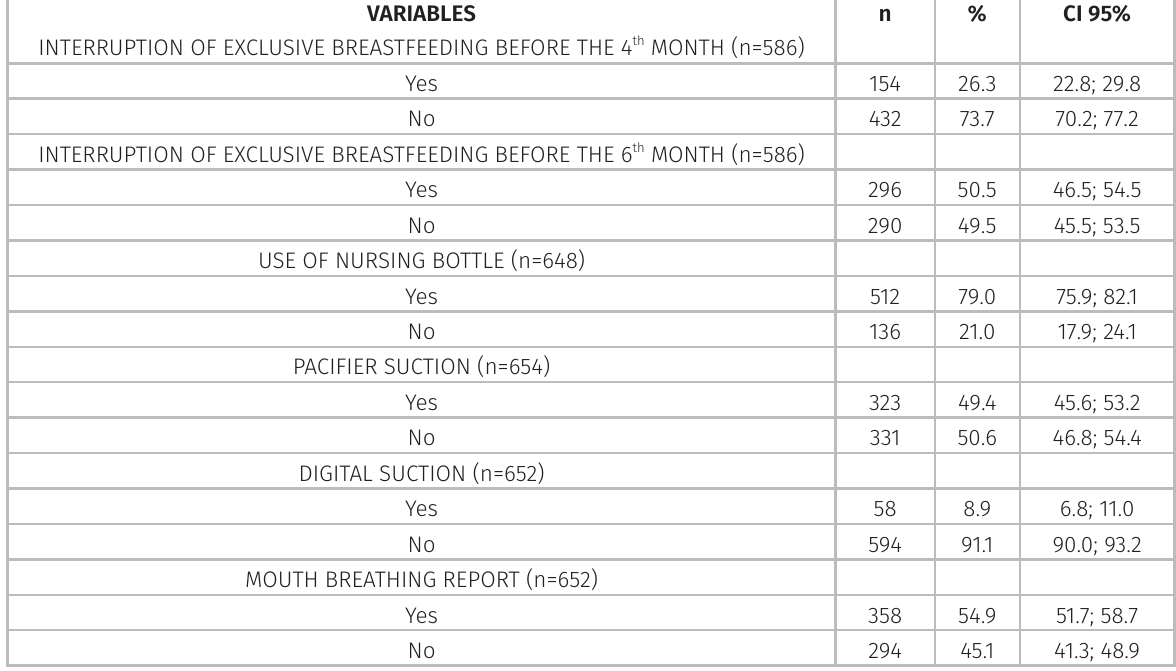
CI 95% = Confidence interval at